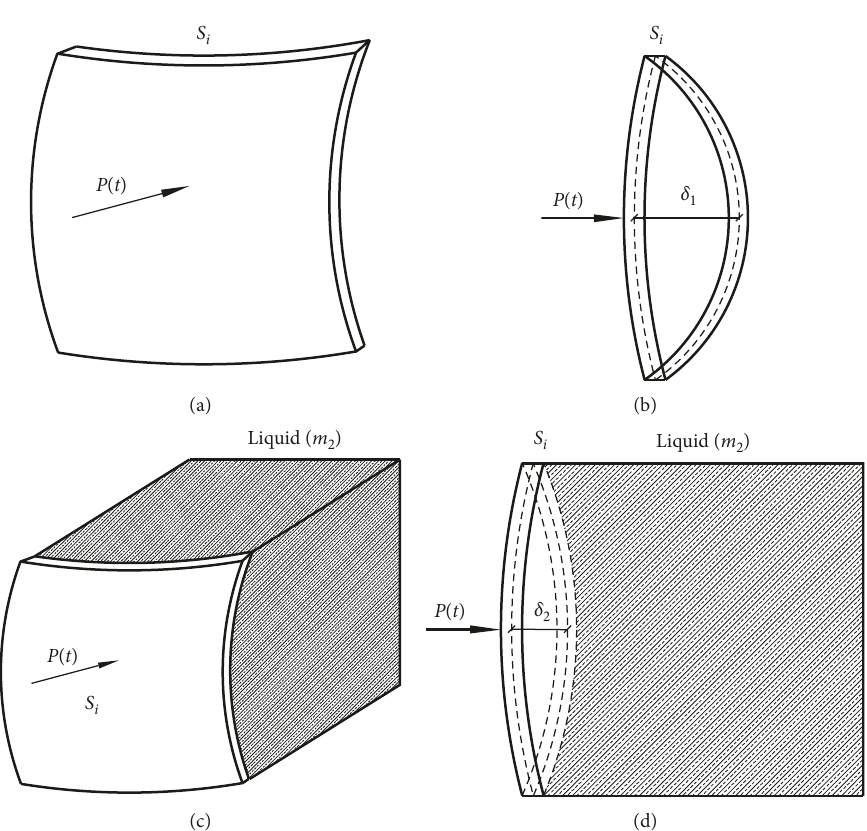
Figure 14: Diagram of shell element S i in two separate conditions. (a) Shell element in empty condition. (b) Deformation displacement of S i . (c) Shell element and added liquid mass. (d) Deformation displacement of shell